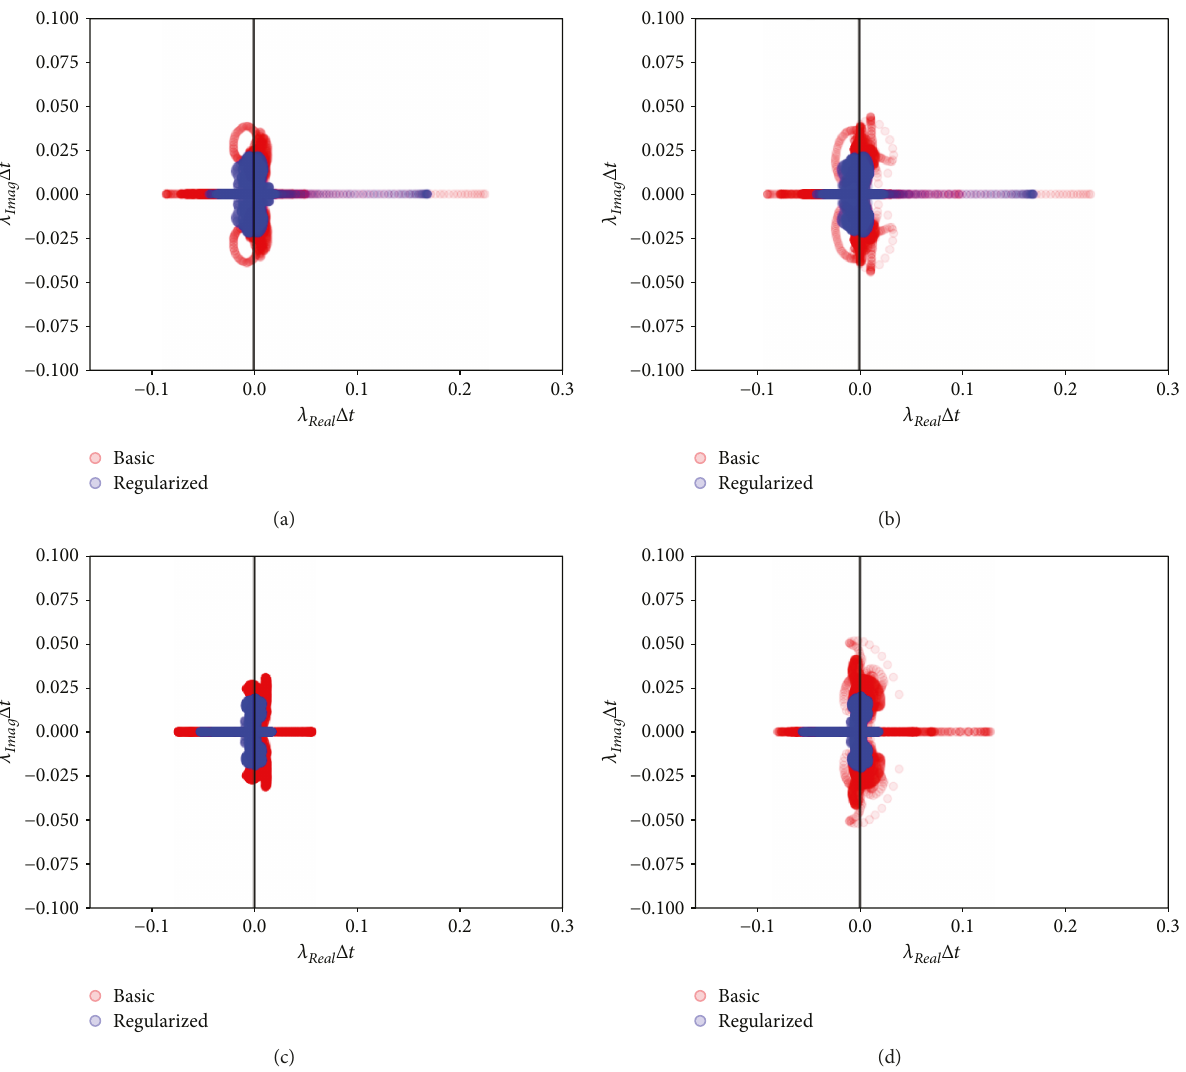
Figure 18: Flow in a cylinder wake. Comparison of linear stability diagram between regularized and basic model. (a) A priori on training data. (b) A posteriori on training data. (c) A priori on testing data. (d) A posteriori on testing